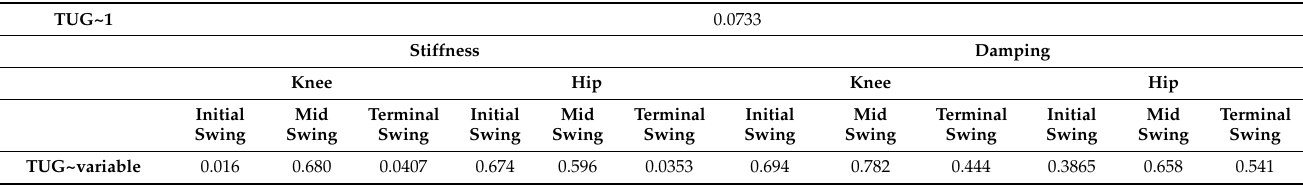
Table 5. p -values of the regression model analysis for TUG and each